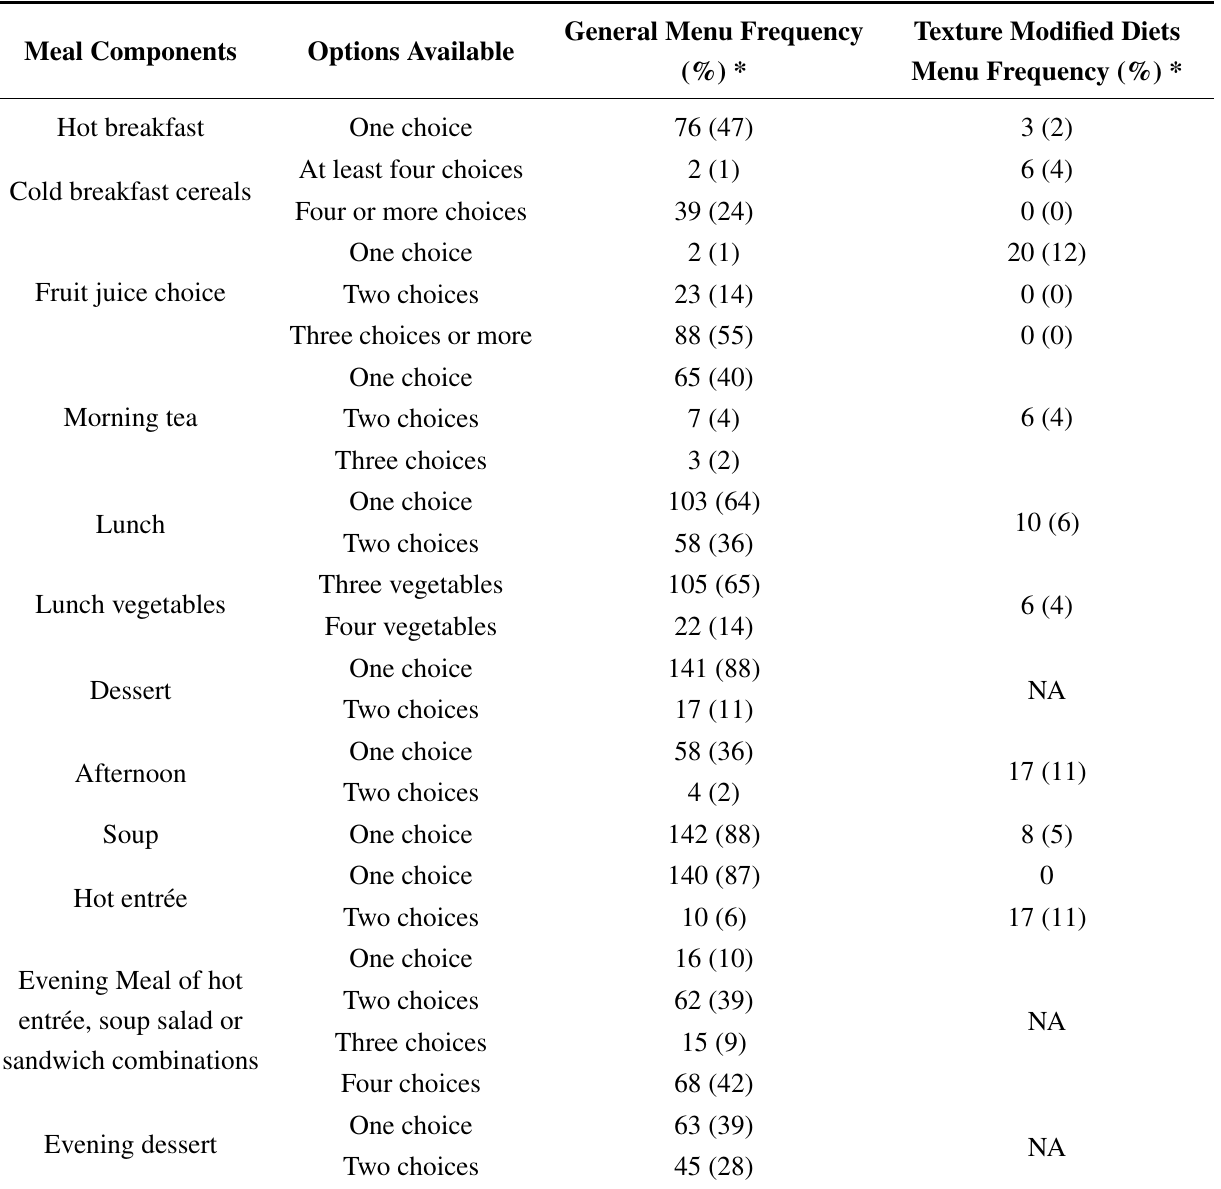
Table 2. Proportion of menus with specific meal components and the choice available for each meal component ( n =